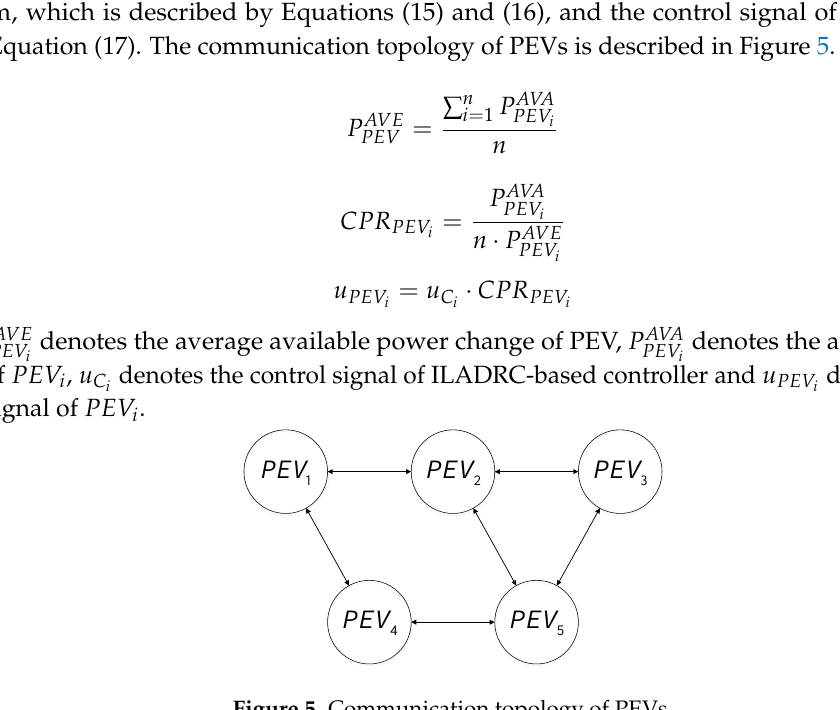
Figure 5. Communication topology of